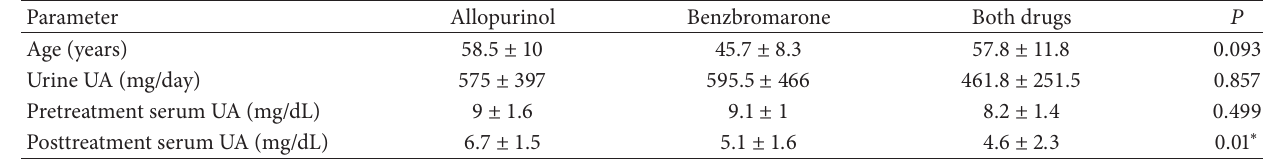
Table 2: Change in serum uric acid (UA) with allopurinol, benzbromarone, or both drugs.